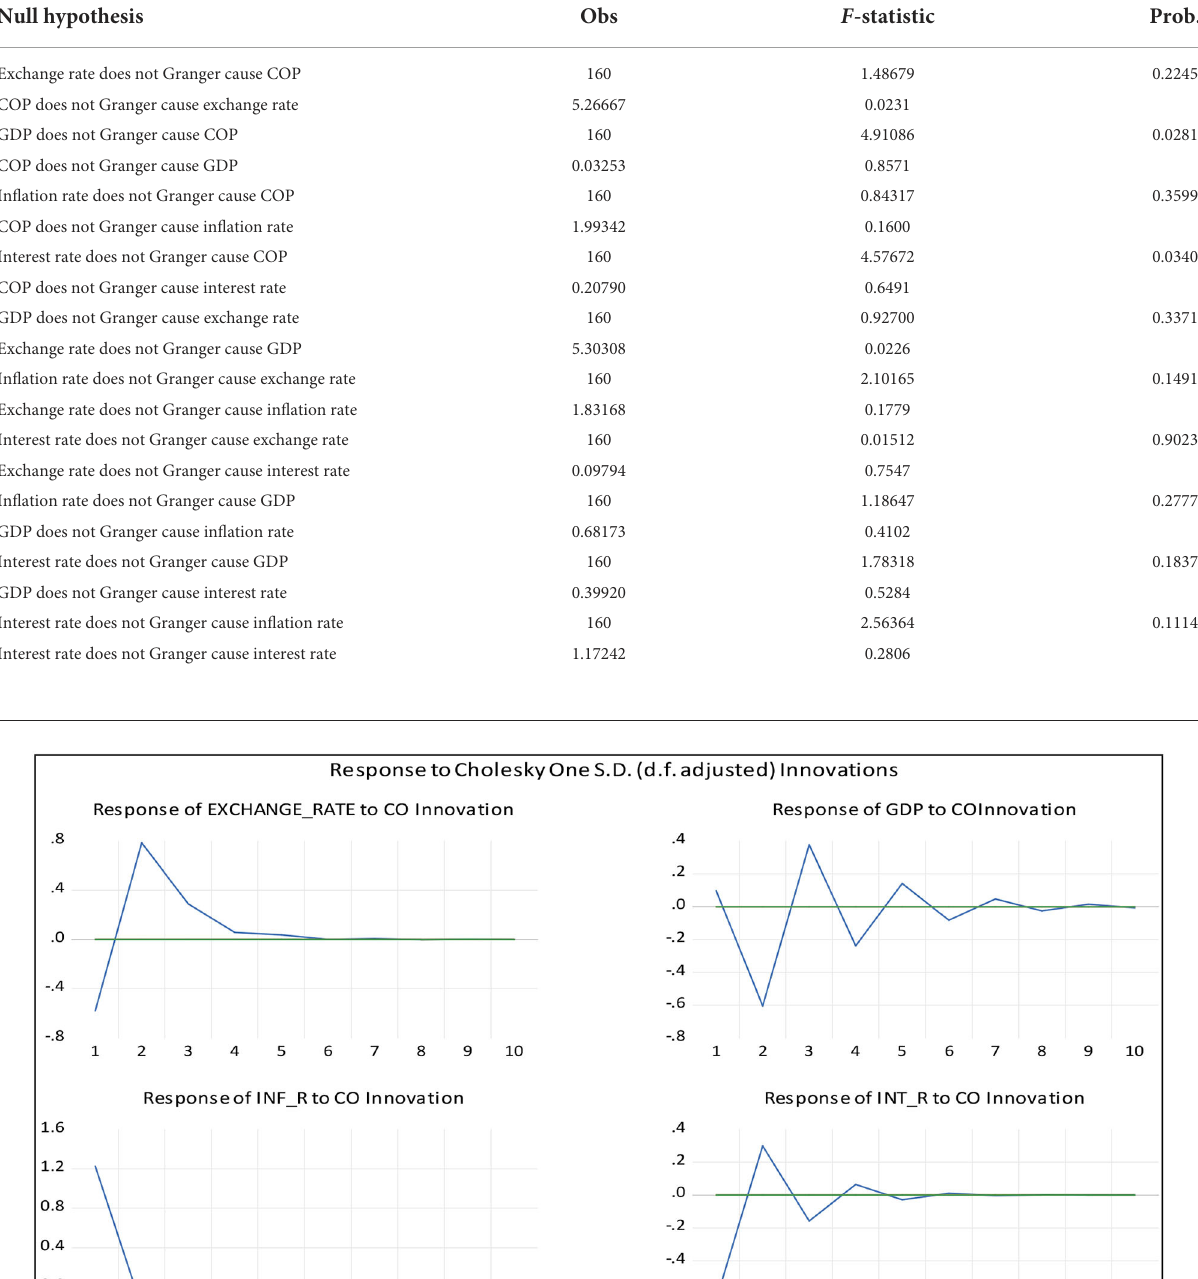
FIGURE1 Impulse response function.